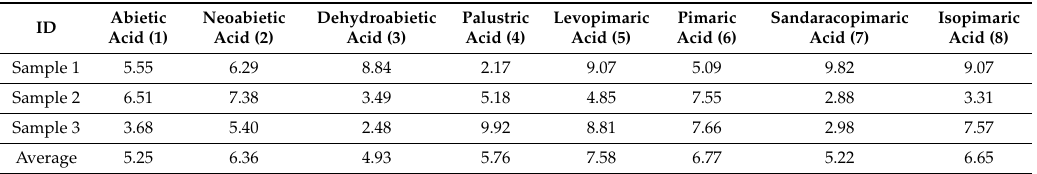
Table 3. Intraday precision data for the studied resin acids, expressed as relative standard deviations (%).